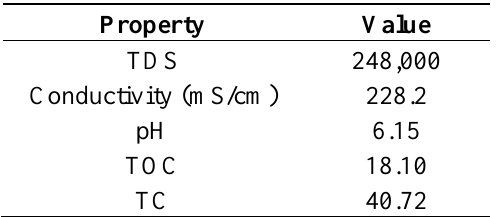
Table 2. Main properties of produced water